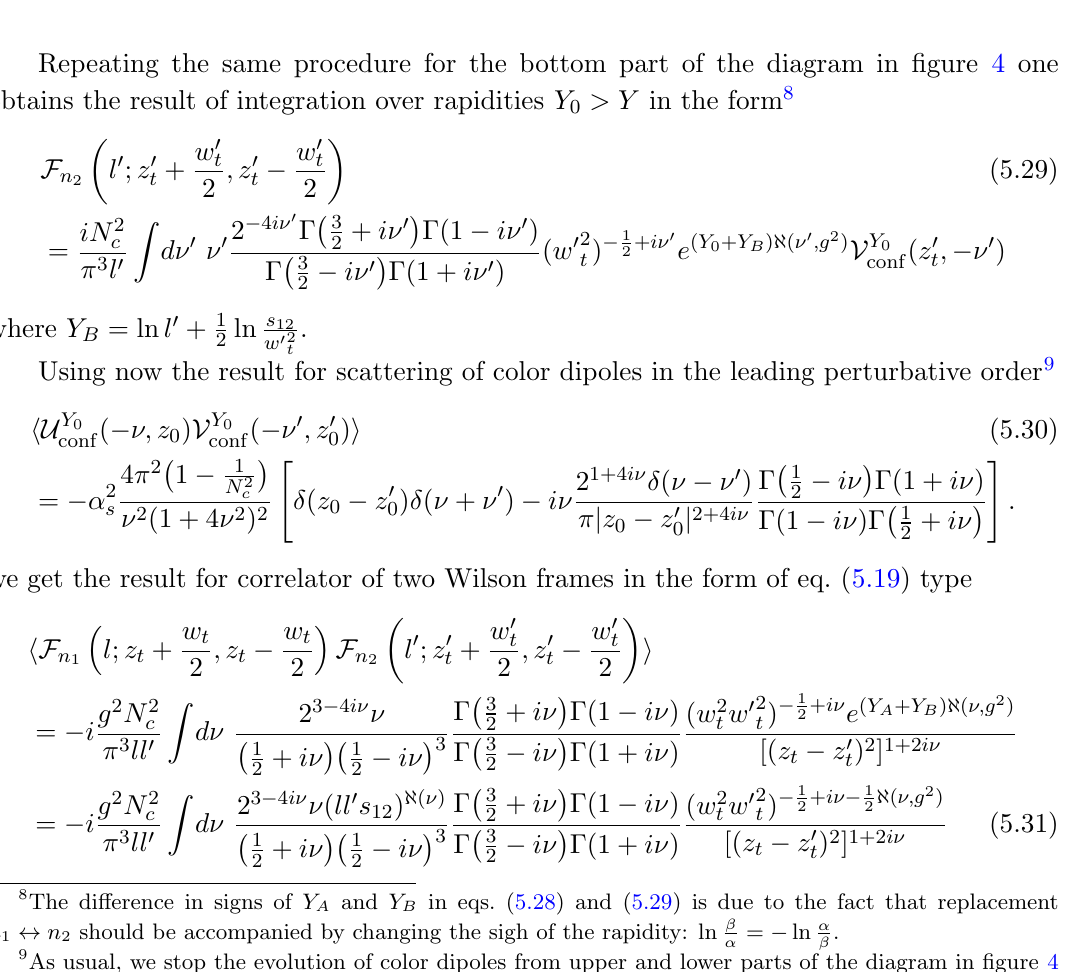
Figure 4 . Correlator of two Wilson frames in the Regge